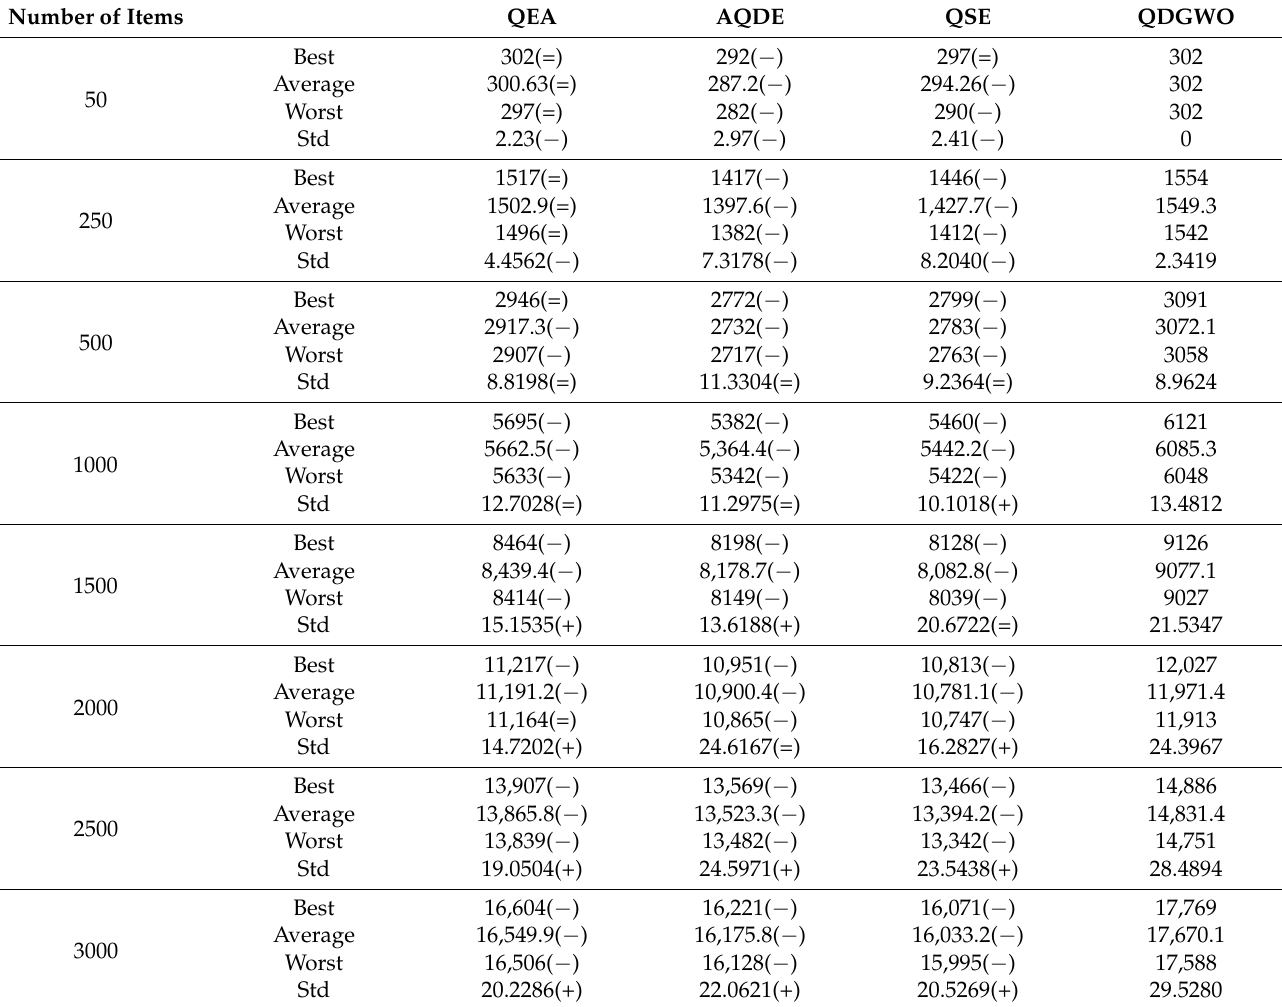
Table 3. Experimental results for 0-1 knapsack problems (Experiment